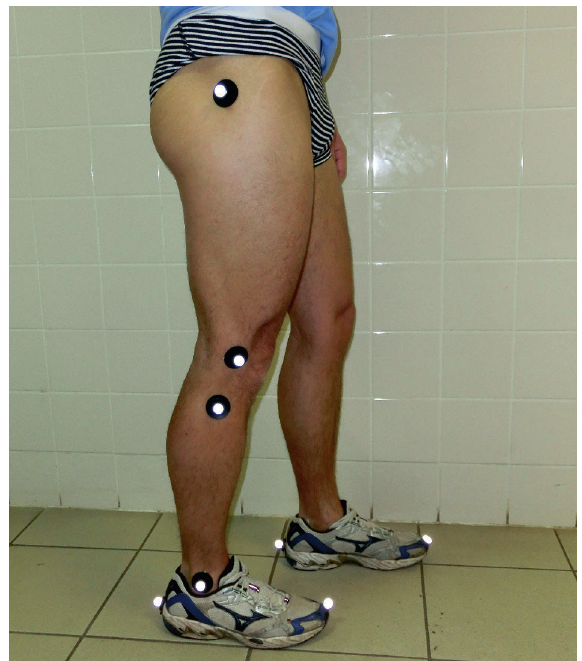
Figure 1. Qualisys marker placement. Each segment vector is defined by pair of markers – foot by the toe and heel markers; shank markers were placed on malle- olus lateralis and lateral condyle of tibia; thigh segment was defined by markers placed on trochanter major and lateral condyle of